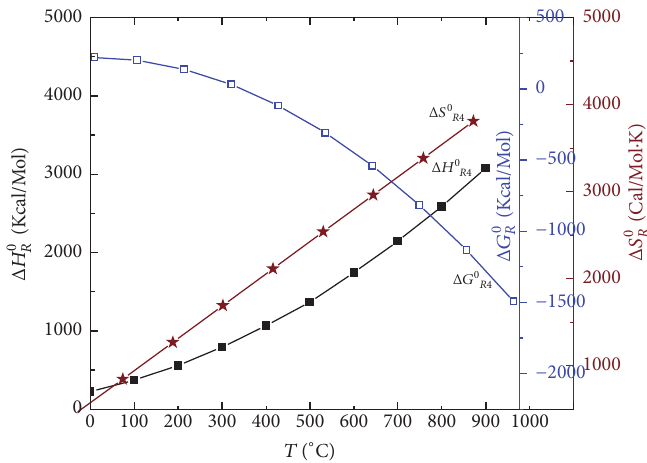
Figure 6: Variation of thermodynamic parameters for cobalt ferrite decomposition.